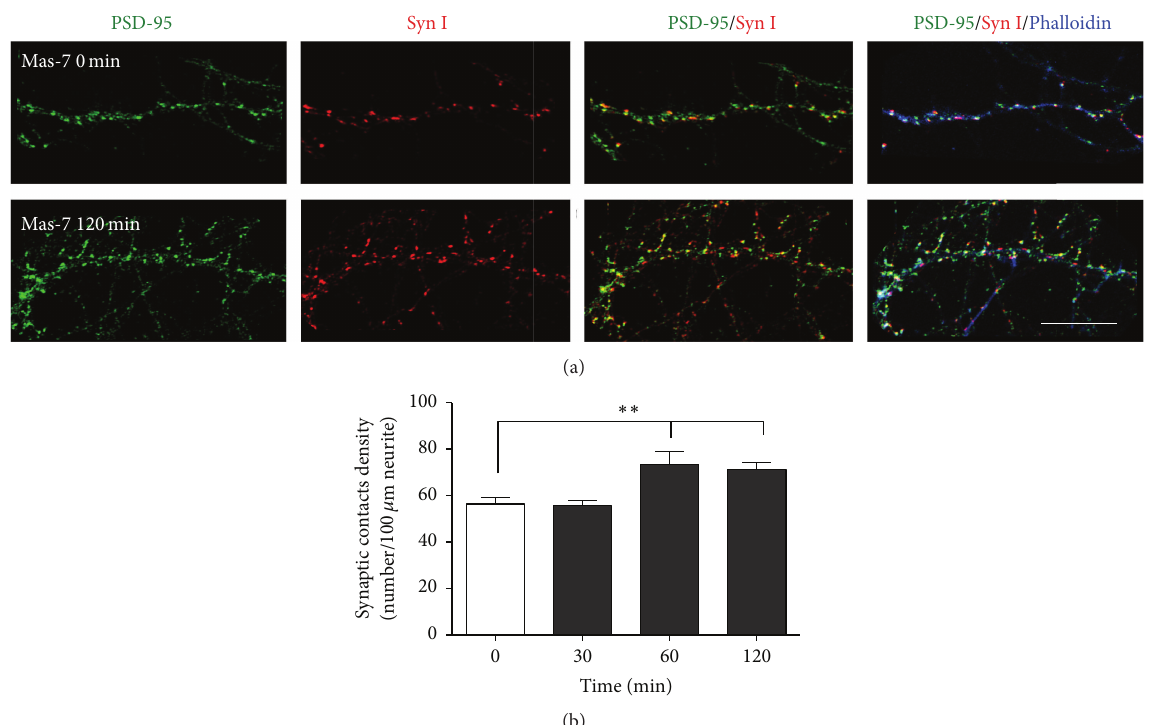
Figure 6: Mas-7 induces the formation of synaptic contacts. (a) Representative images of hippocampal neurons at 14 DIV treated with 1 𝜇 M Mas-7 for 0 or 120min. PSD-95 (green), SynI (red), and Phalloidin (blue) immunofluorescence. Scale bar = 4 𝜇 m. (b) Quantification of the density of synaptic contacts (10 neurons were analyzed in each experiment). ∗∗ 𝑝 < 0.01